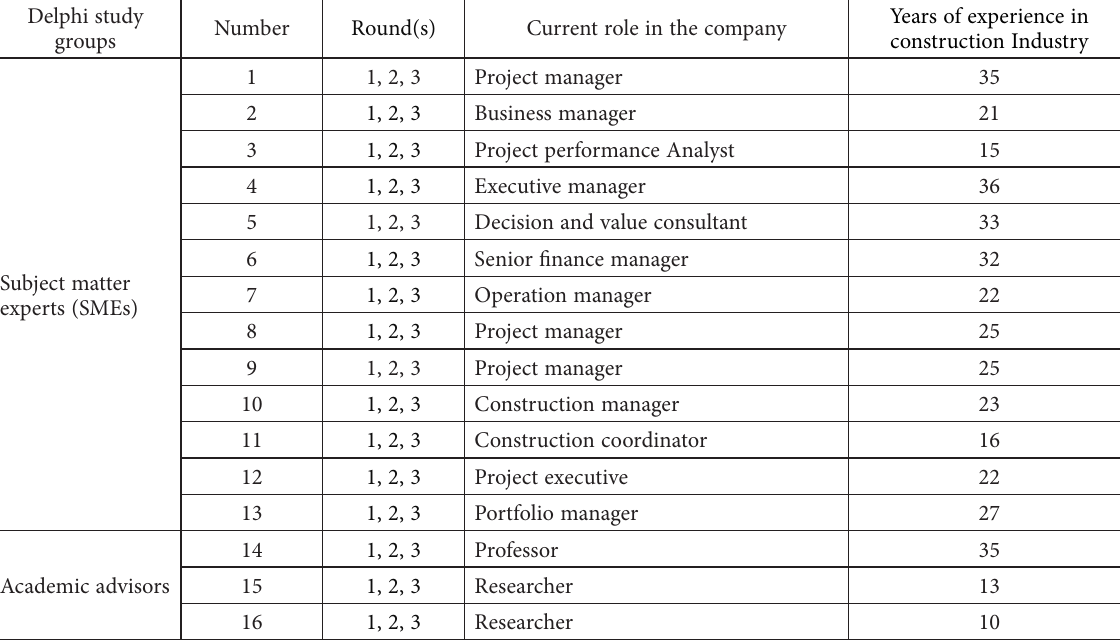
Table 1. Expert participants’ demographic information in the